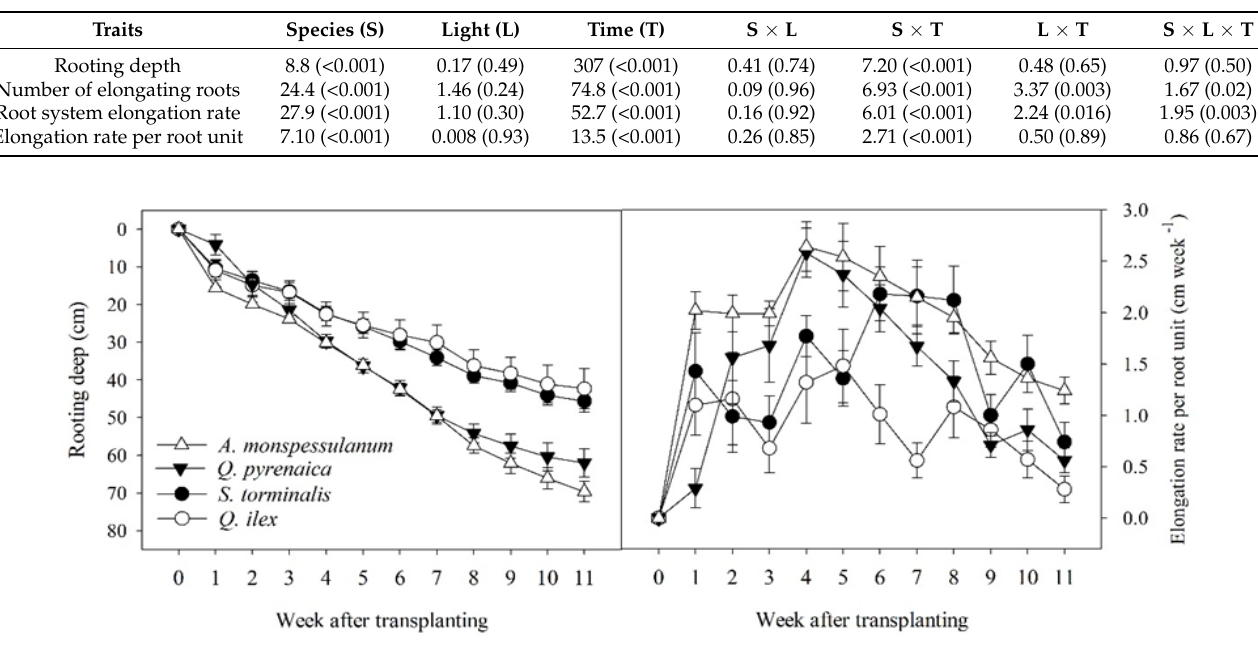
Figure 2. Rooting depth ( left ) and elongation rate per root unit ( right ) in seedlings of four broadleaf Mediterranean tree species grown in rhizotrons. Data are mean and ± one SE.